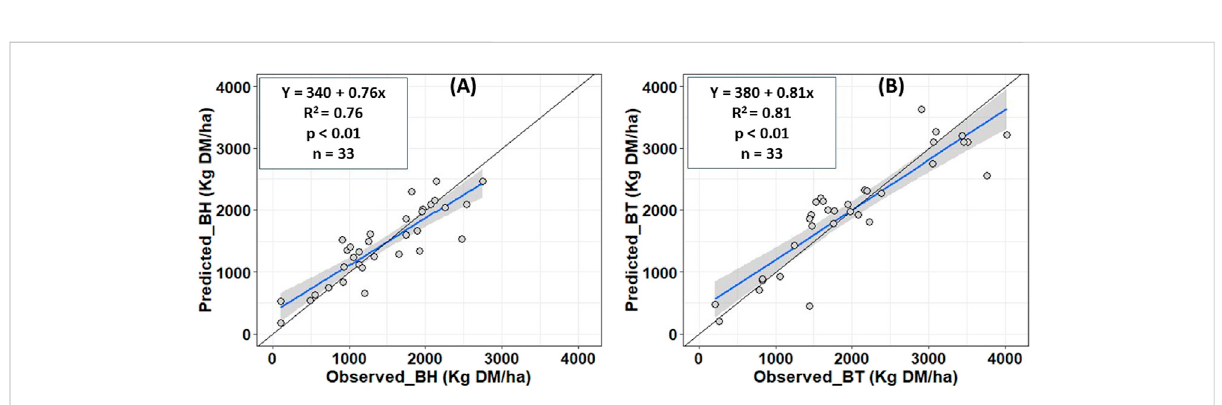
FIGURE 6 Scatterplot between observed and predicted (data over all the three periods) data using the best model for each dry mass variable with (A) : BH and (B) : BT.